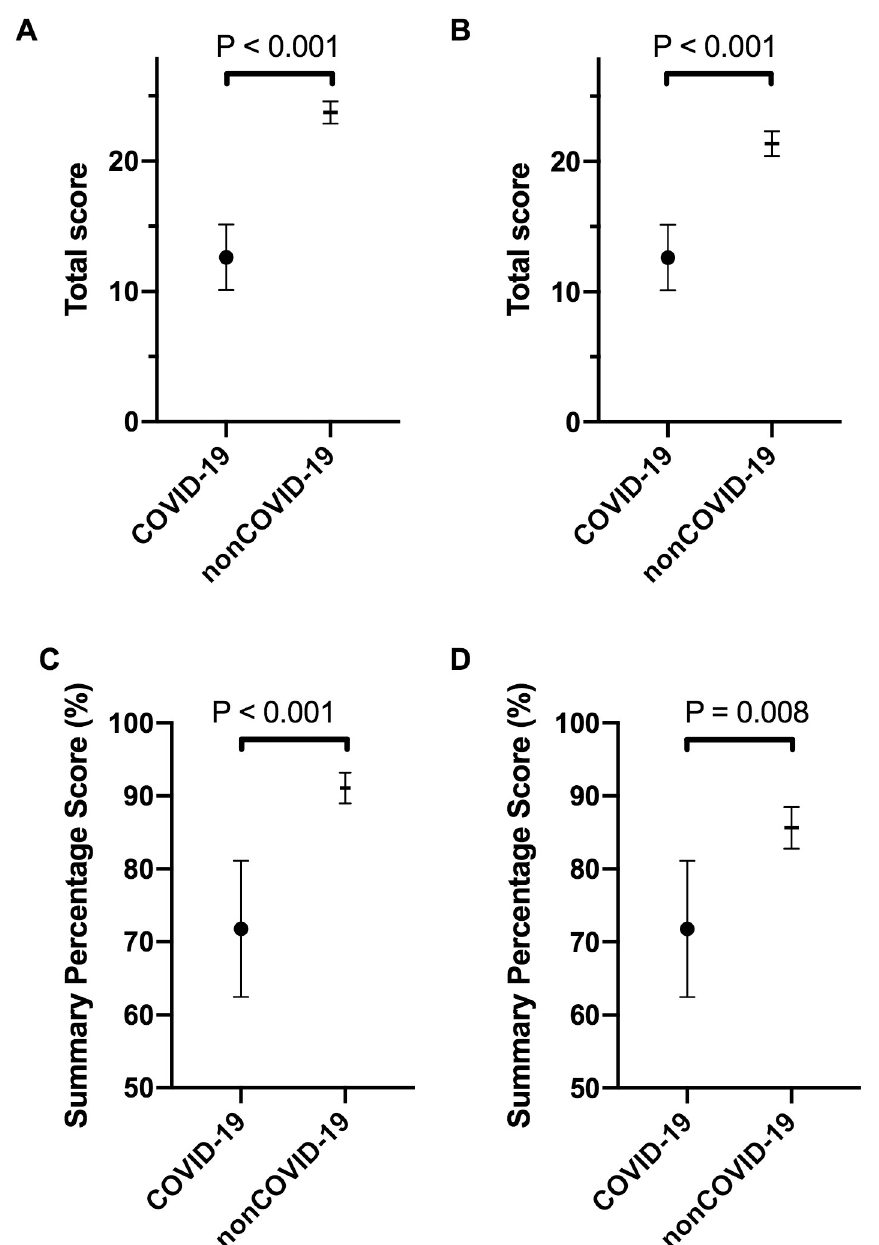
Fig 2. Quantitative appraisal of the quality of the COVID-19 versus nonCOVID-19 original articles. The “Standard quality assessment criteria for evaluating primary research papers from a variety of fields” 25 was used, for a maximum total score of 28. ( A, C ) Primary analysis for mean total scores (A) and mean summary percentage scores (C) for all COVID-19 (n = 13) and nonCOVID-19 (n = 52) original articles. ( B, D ) Secondary analysis for mean total scores (B) and mean summary percentage scores (D) that included all of the COVID-19 original articles (n = 13) and the lower quality half of the nonCOVID-19 original articles (n = 26). Data are means with 95% CI. An adjusted threshold P value of 0.025 defines significance (adjusted for multiple testing. Welch’s